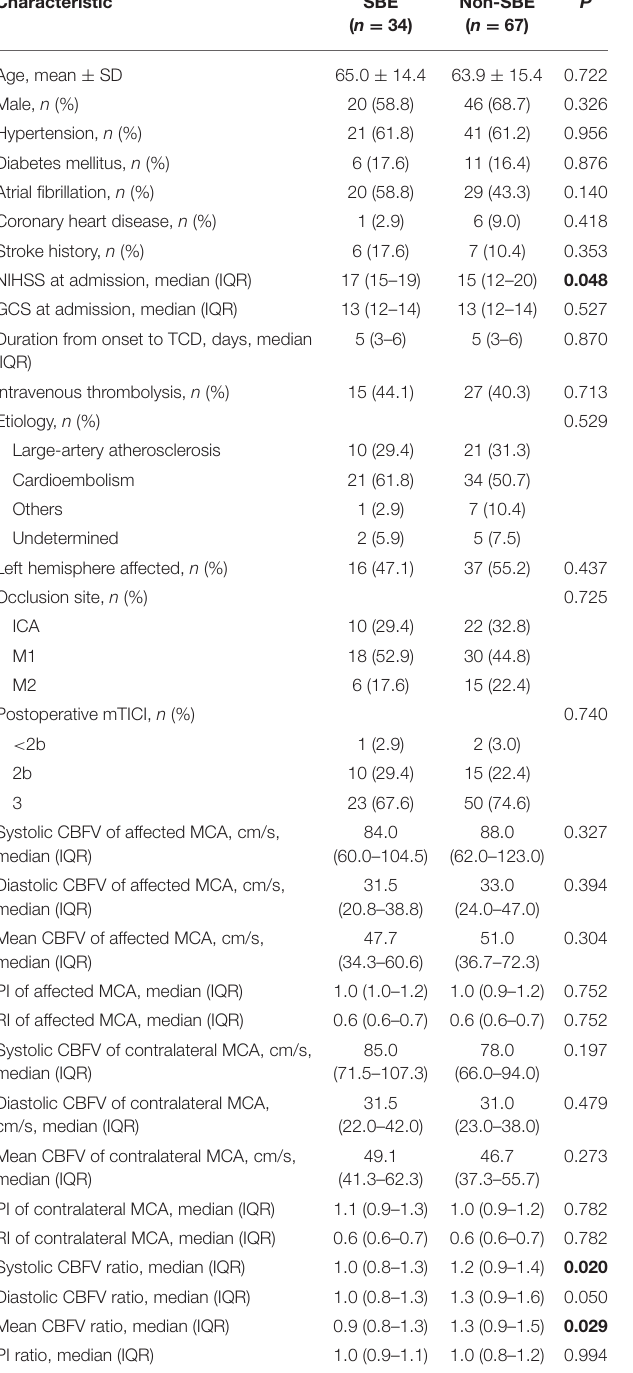
TABLE 3 | Multivariate analysis of the association between the ratio of cerebral TABLE 2 | Comparison of baseline characteristics between patients with or blood flow velocity and severe brain edema. without severe brain edema (SBE). Characteristic SBE Multivariate regression model OR ( n = 34)